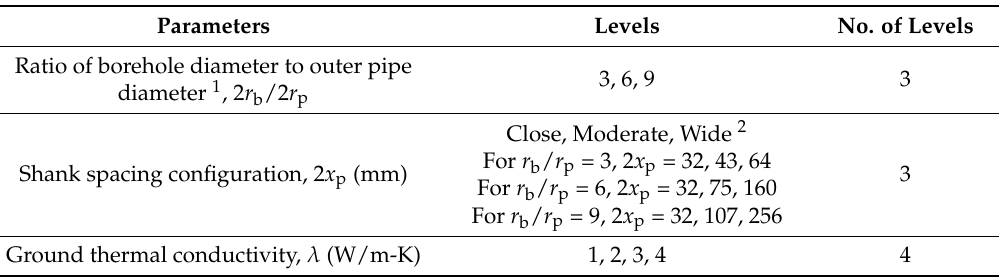
Table 1. Summary of comparison cases provided by [13].